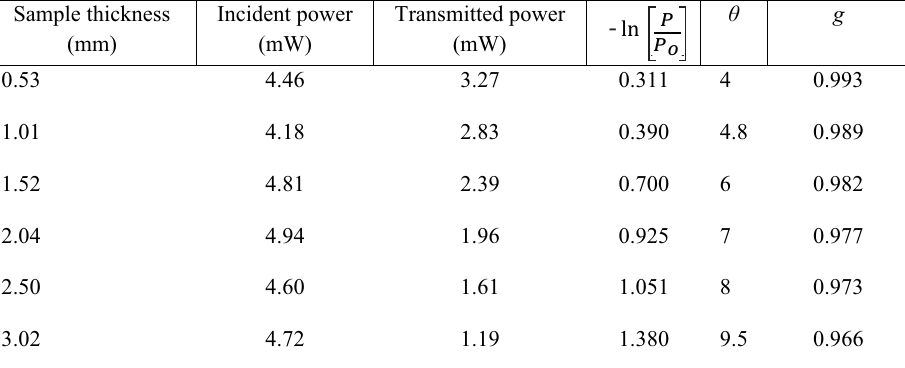
Table 2. Power intensities of the 630 nm laser through 60 g/L of borax with 100 mL of slime glue, and 0.4 mL of India ink to assess the effects of added